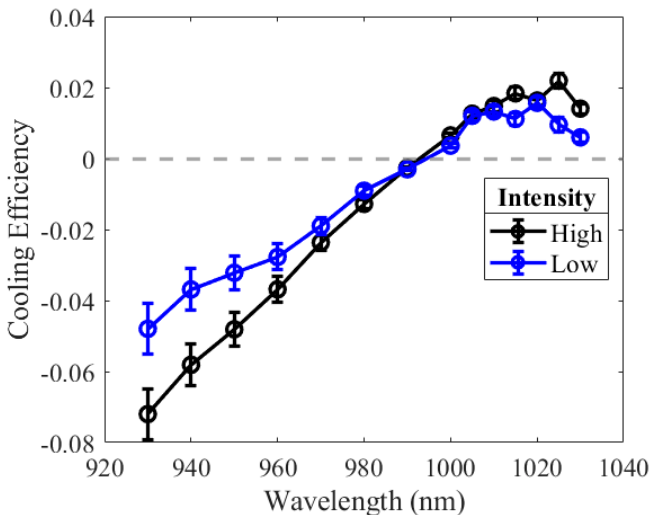
Table 1. Pump beam radius (half-width at 1/e 2 intensity) and intensity values used for the measure- ments presented in Figures 11 and 12. Entries indicate the small variations of intensity at multiple wavelengths for each intensity category.